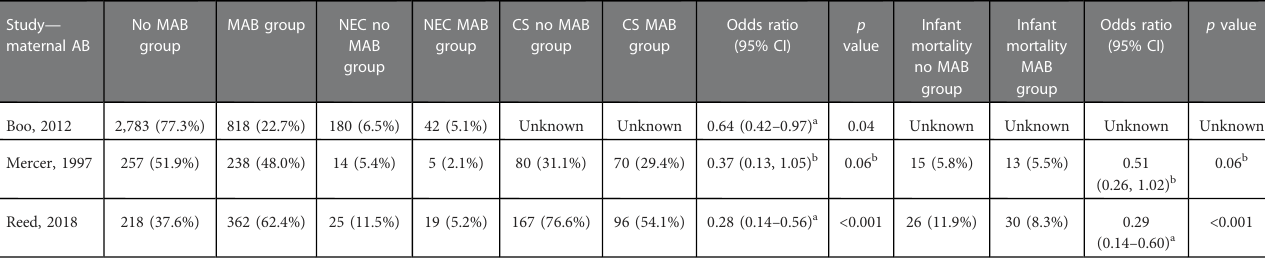
TABLE 2 Maternal antibiotics use compared with no maternal antibiotics